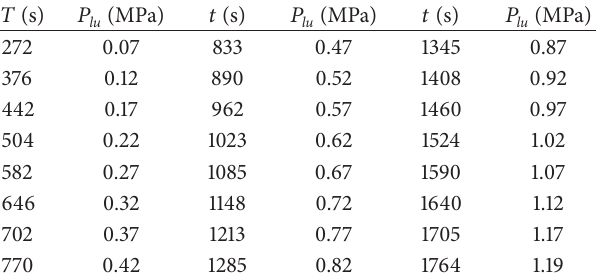
Table 2: Outlet pressures of centrifugal pump versus